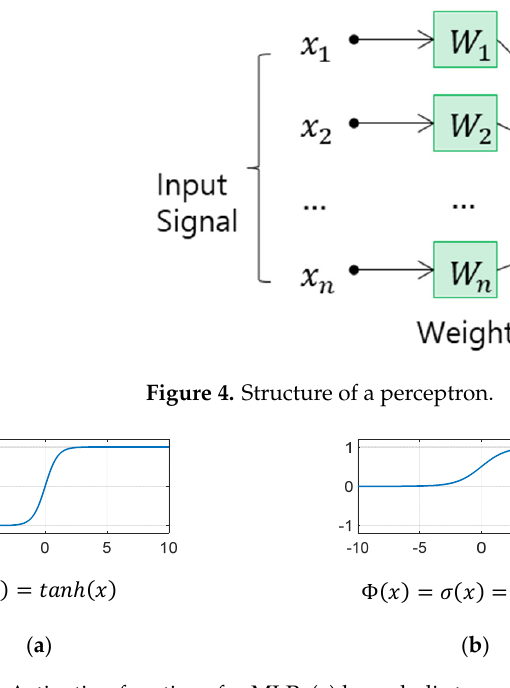
Figure 5. Activation functions for MLP: ( a ) hyperbolic tangent function; ( b ) sigmoid Function; ( c ) ReLU function.